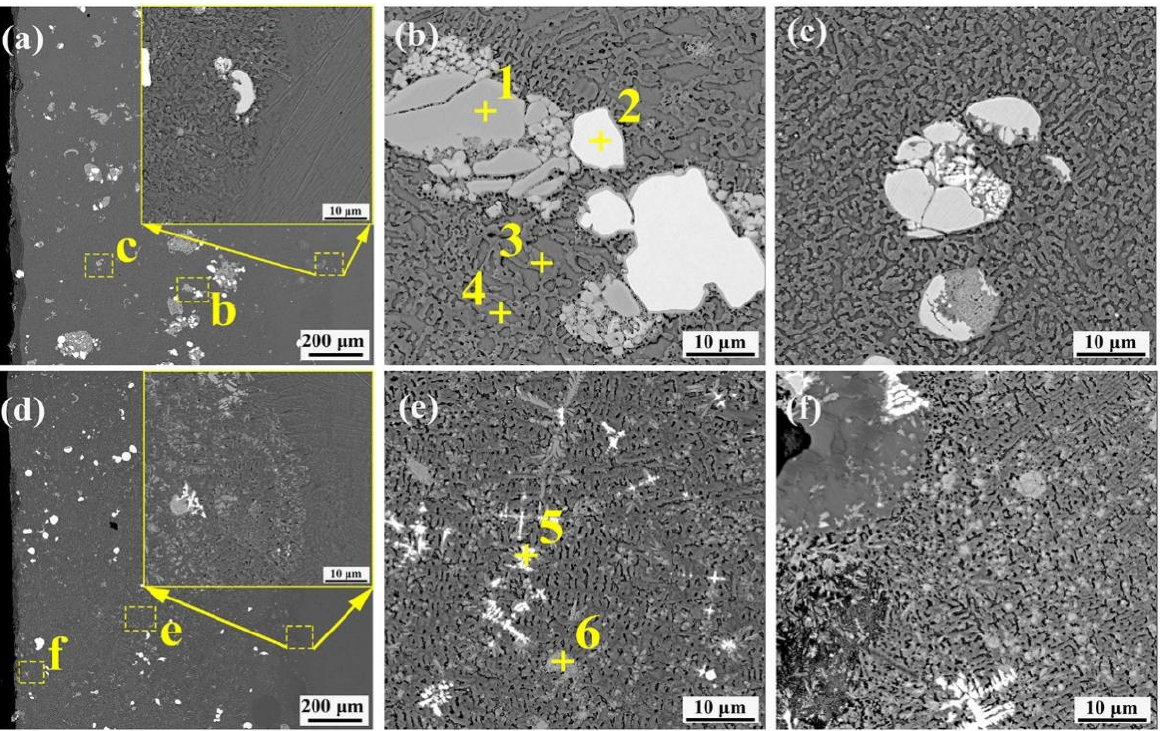
Figure 5. Cross-sectional morphology of the Ni–Cu–10(Mo,W,Si) and Ni–Cu–15(Mo,W,Si) coatings: ( a ) cross-sectional morphology of the Ni–Cu–10(Mo,W,Si) coating; ( b ) structure of the upper area of the Ni–Cu–10(Mo,W,Si) coating; ( c ) structure of the middle area of the Ni–Cu–10(Mo,W,Si) coating; ( d ) cross-sectional morphology of the Ni–Cu–15(Mo,W,Si) coating; ( e ) structure of the middle area of the Ni–Cu–15(Mo,W,Si) coating; ( f ) structure of the upper area of the Ni–Cu–15(Mo,W,Si) coating. According to the microstructural and elemental contents detailed in Table 3, large particles of the coating were unmelted Mo and W fragments (point 1 and Point 2). The crystal structure was mainly composed of Ni–Cu solid solution and Ni x Si y phase (point 4). The enrichment of Si at grain boundaries of the Ni–Cu–10(Mo,W,Si) coatings (point 3) was similar to that of the Ni–Cu–10(W,Si) coatings. White (point 5) phases were inferred to be WSi 2 , (Mo,W)Si 2 . Infinite solid solutions of the (Mo,W)Si 2 mixed phase were generated from WSi 2 and MoSi 2 due to their similar crystalline structure. Grey phases (point 6) were inferred to be MoSi 2 and (Mo,W)Si 2 . Mo 5 Si 3 may also exist in grey phases because of insufficient Si contents. Table 3. EDS elemental composition (at.%) of the coatings shown in Figure 5 .